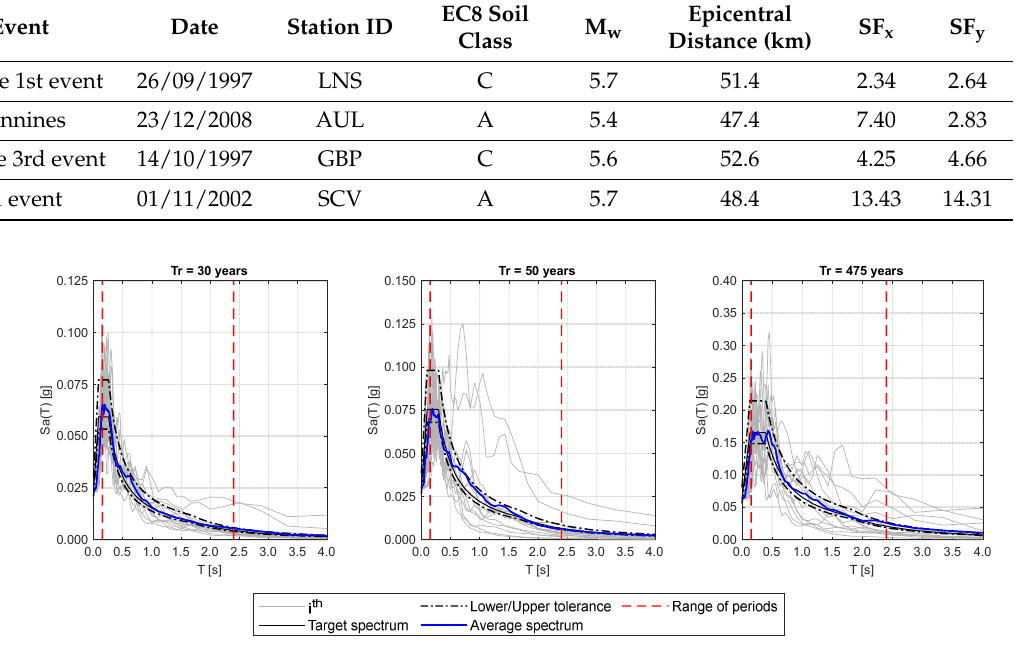
Figure 6. Acceleration response spectra of the real accelerograms selected using Rexel and comparison of their average spectrum (blue line) with the reference code spectrum (black continuous line) for the considered return periods of the seismic action (Tr).